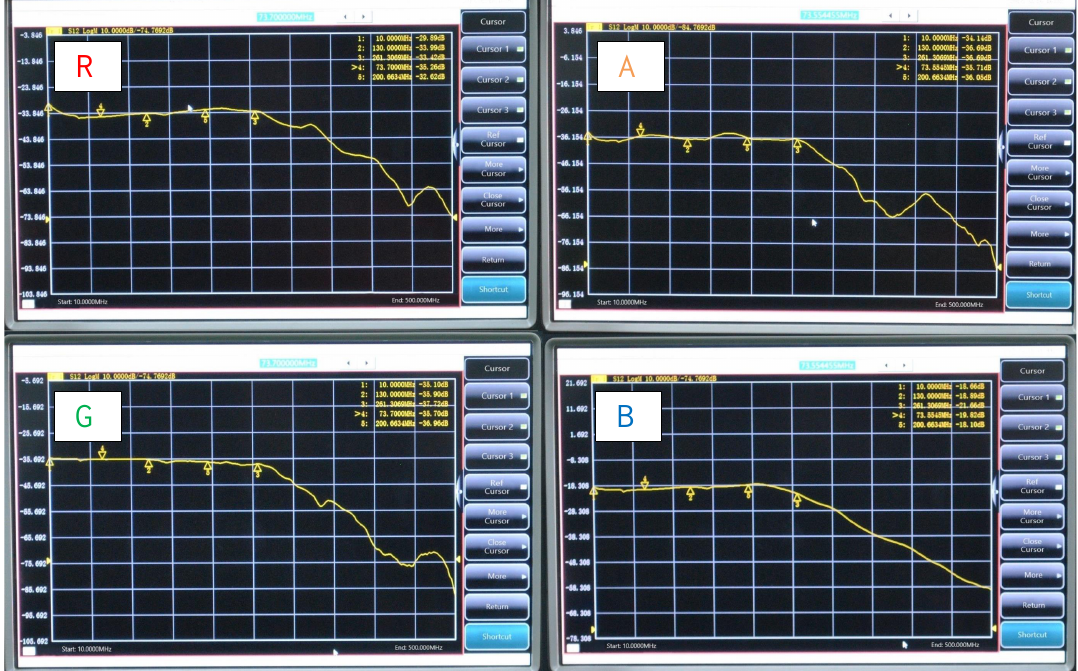
Figure 3. The amplitude-frequency response characteristics of multiple colors after pre-equalization.